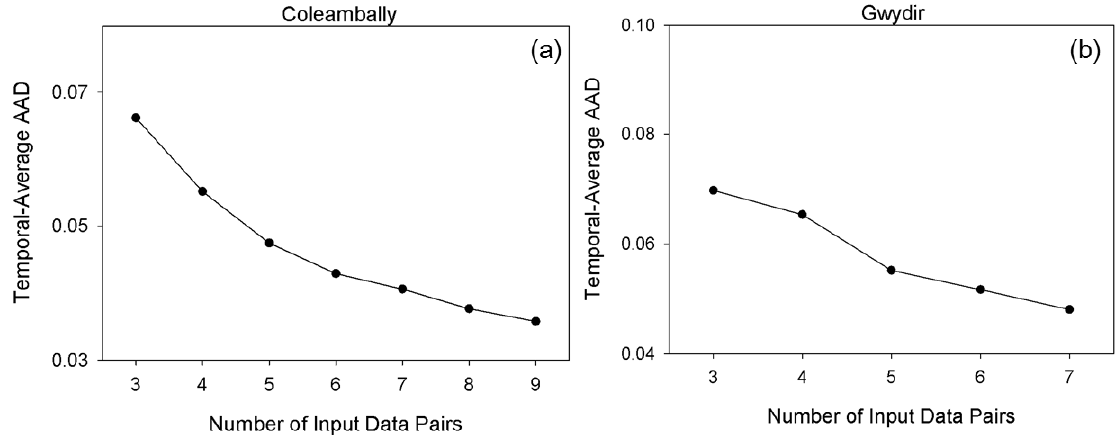
Figure 12. Averaged AAD for all prediction dates against the number of input data pairs at ( a ) the Coleambally site and ( b ) the Gwydir